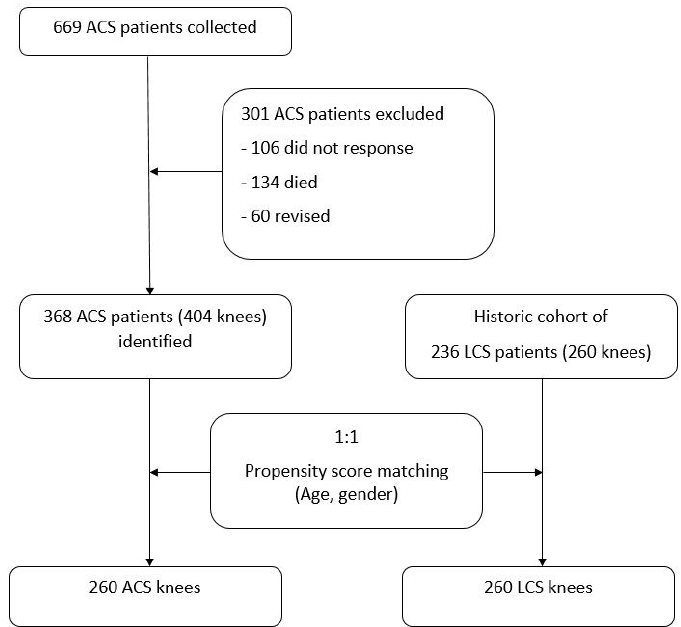
Figure 4. Flow chart of study inclusion.